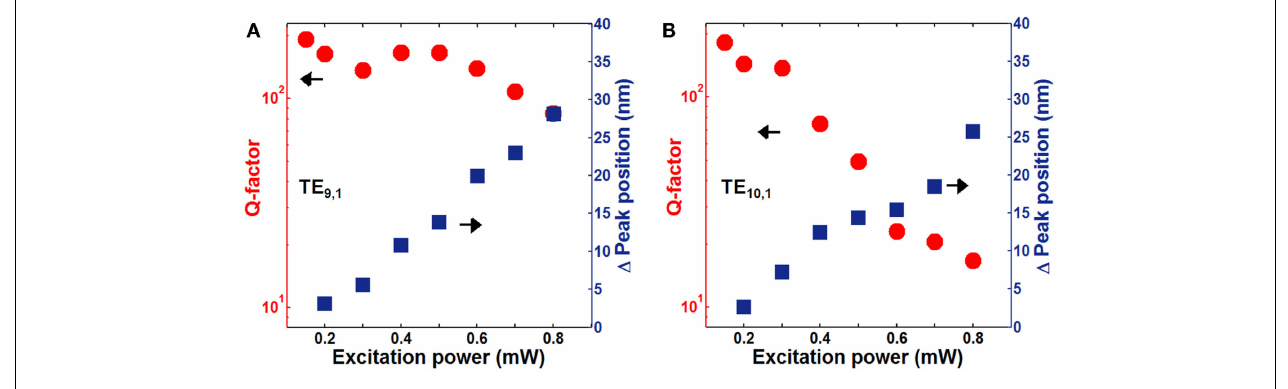
red-shift of direct-gap absorption edge of Ge with increasing excitation power due to heating, in addition to FCA losses. While TE 9,1 being less affected by the Ge direct-gap absorption, undergoes increasing FCA losses with higher pumping